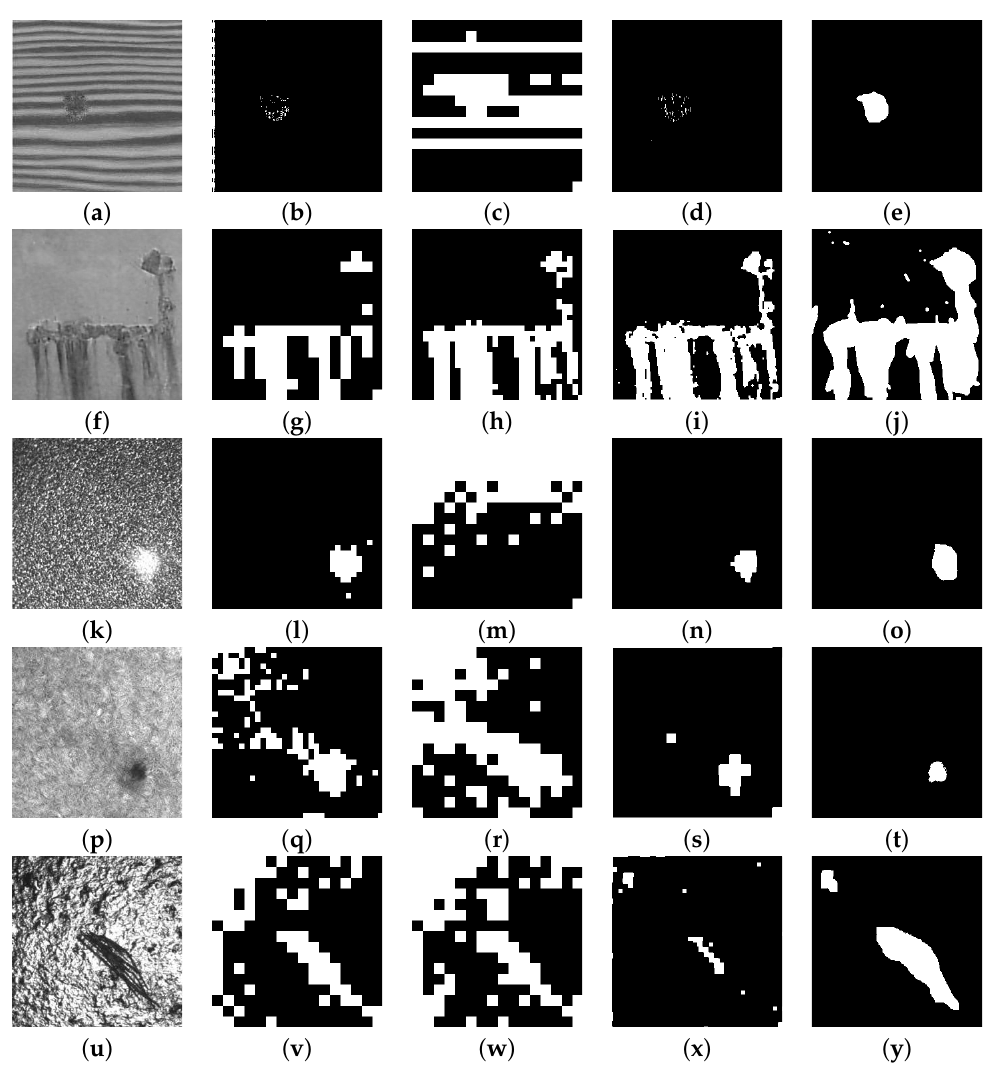
Figure 10. Defects in different statistical textures: ( a ) wood, ( f ) painted surface, ( k ) sandpaper, ( p ) wool, ( u ) cast metal; ( b , g , l , q , v ) are the images resulting from the Tsai method; ( c , h , m , r , w ) are the images resulting from the Han method; ( d , i , n , s , x ) are the images resulting from the EADL method; ( e , j , o , t , y ) are the pattern images resulting from segmentation carried out by human